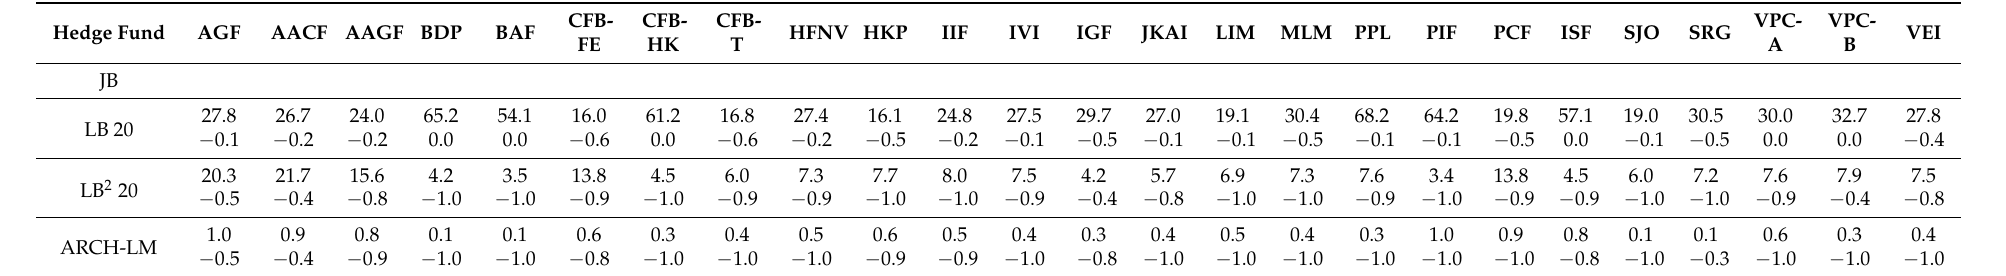
Table A6. Diagnostics for the EGARCH Residuals—Hedge Funds